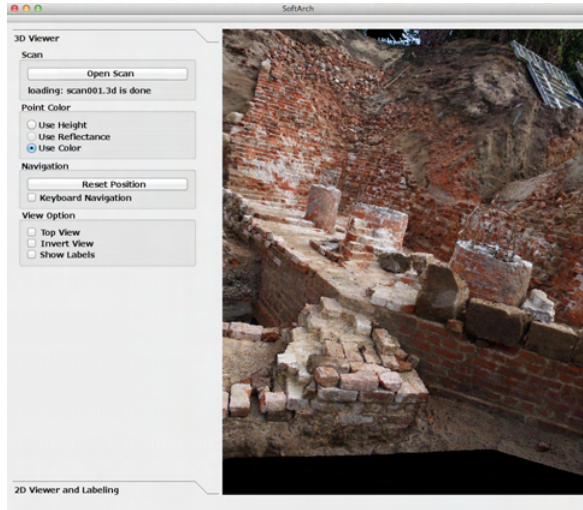
Figure 3: 3D viewer of Castle3D software. Presenting an exca- vation site in Bremen,